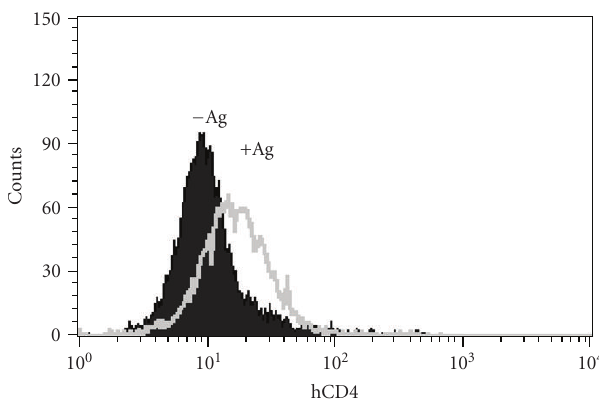
Figure 1: Human CD8 + CTL specific for the cytomegalovirus N9V Ag capture CD4 from T2 target cells. Human CD8 + T cells were incubated for 1 hour with T2 cells, which express CD4 and HLA- A2.1 naturally, that had been loaded (+Ag) or not ( − Ag) with the N9V peptide. Cells were then analyzed by flow cytometry for CD4 and CD8 expression. Shown are overlapping histograms of CD4 expression on gated CD8 + T cells. Similar results were obtained in 3